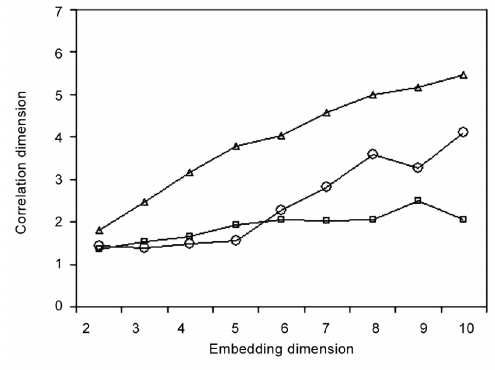
Fig. 8. Correlation dimension versus embedding dimension of 1000 data waiting times sequences (complete catalogue) after largest events: circles – time period before beginning of experiments (1975- 1983); squares – time period during experiments (1983-1988); triangles – time period after accom- plishing of experiments